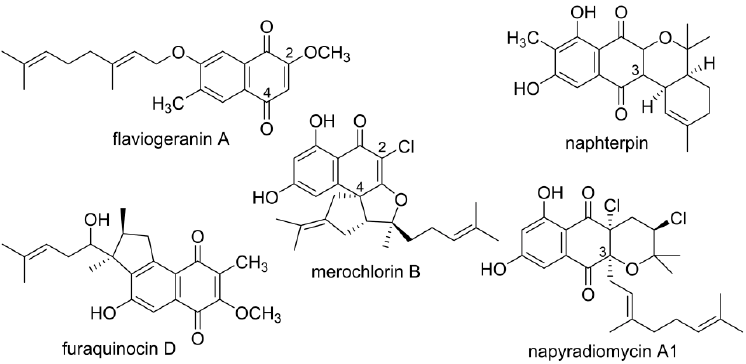
Figure 1. Representative naphthoquinone-based meroterpenoids.